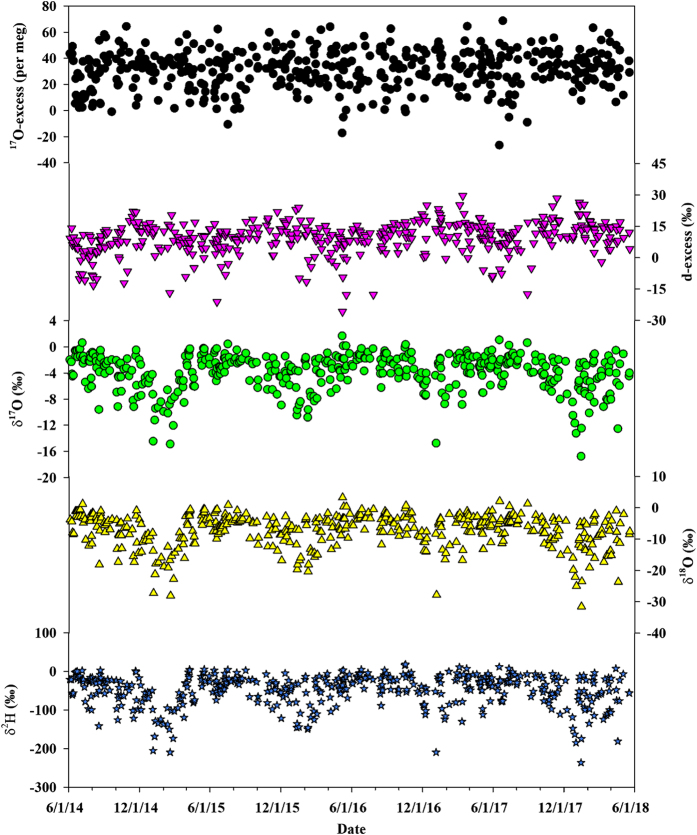
δ2H, δ18O and δ17O, as well as the d-excess and 17O-excess values of daily precipitation from June 2014 to May 2018 in Indianapolis, Indiana, U.S.